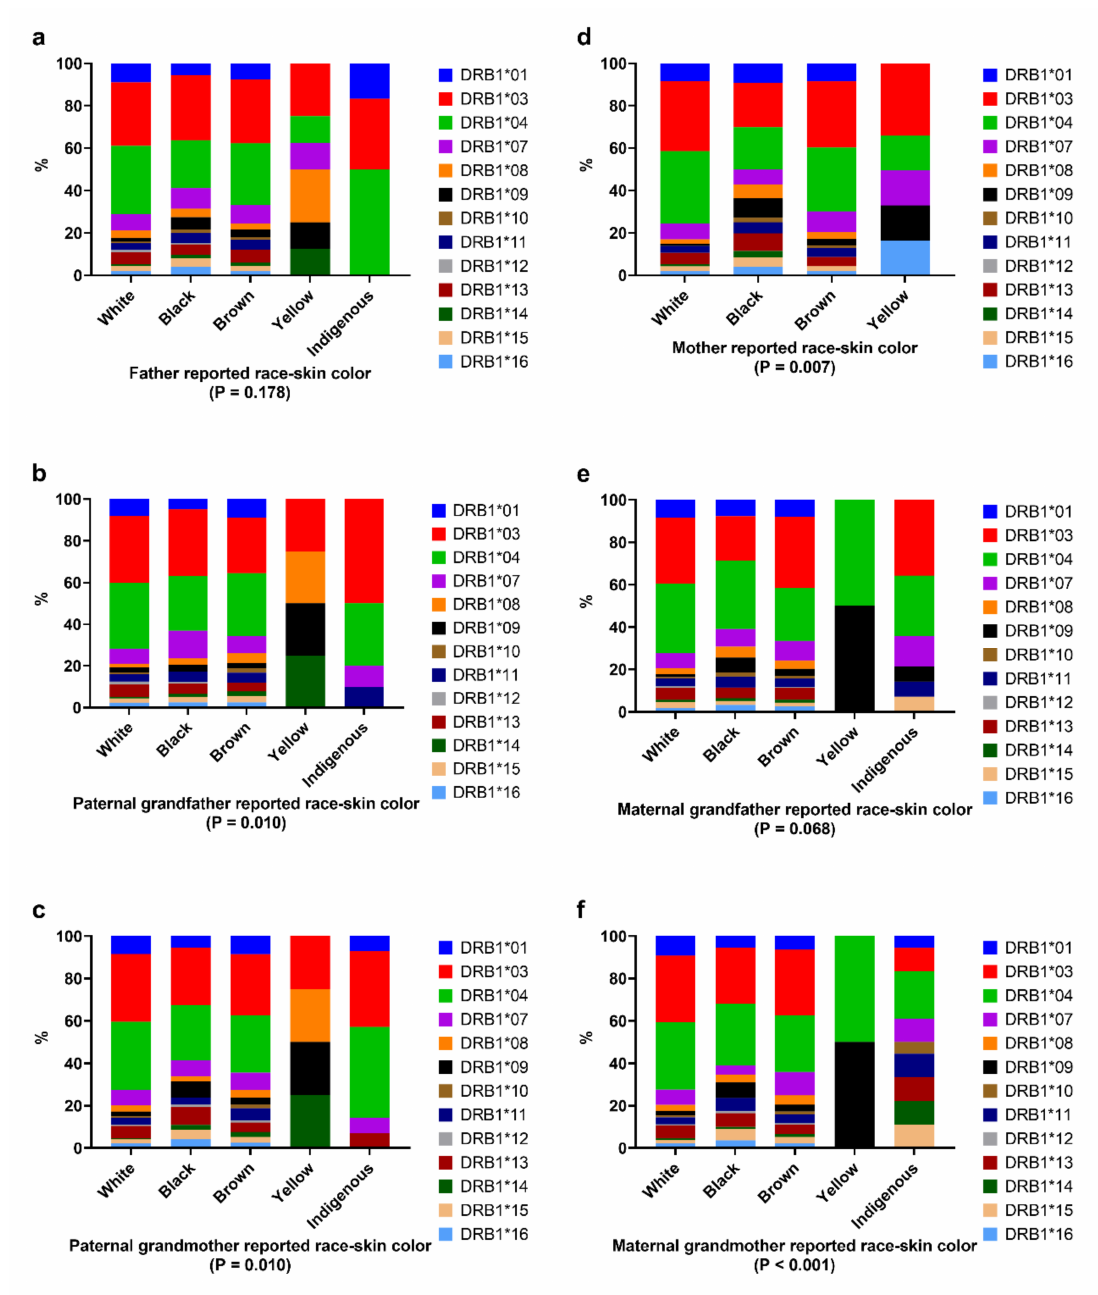
Figure 2. Distribution of HLA-DRB1 alleles according to reported race/skin color from paternal relatives ( a – c ) and maternal relatives ( d – f ). Chi-square test was performed for statistical analysis. A total of 186 patients (28.09%) reported any degree relative as being Black (Supple- mentary Table S7), and 73.65% reported at least one relative as being White. In this group, a higher frequency of patients carrying the - DRB1*03:01 allele in homozygous or heterozy- gous genotypes was observed (42.52%). The genotype combination -DRB1*03:01/03:01 followed by -DRB1*03:01/04:04 was the most frequently found. Patients who reported only Black relatives up to the 3rd generation ( n = 9, 4.83%) had no predominance of any DRB1 genotype (Supplementary Table